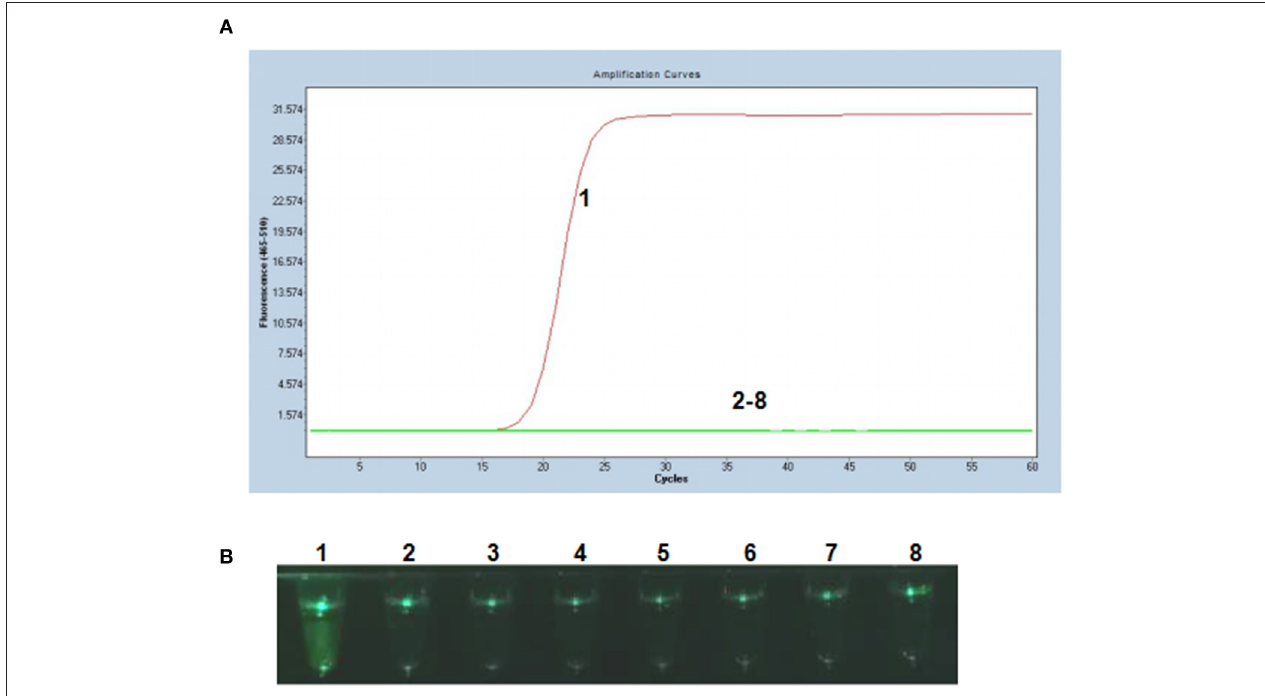
FIGURE 2 | Specificity of the P-S-MCDA assay for PCV3. (A) Specificity of P-S-MCDA by the Roche Light Cycler 480 II. (B) Specificity of P-S-MCDA by the smartphone-based cassette. Lane or Tube 1, 10 5 copies of pMD19T-capsid plasmid DNA. Lanes or Tubes 2–8, ddH 2 O, PCV2, PCV1, PRV GD-WH strain, HPS, SS, and APP,